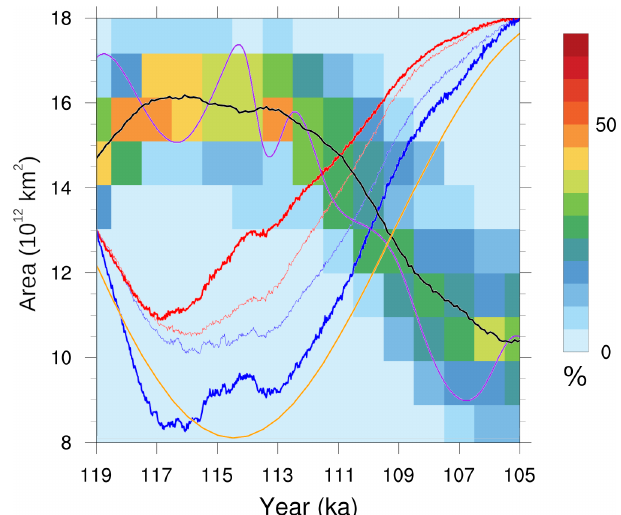
Figure 12. The ensemble distribution of Northern Hemisphere late summer sea ice total area. The black line shows the ensemble mean late summer sea ice area. The blue lines show the scaled ensemble mean summer temperature anomaly with respect to 119ka in NA (thick) and EA (thin). The red lines show the scaled ensemble mean annual precipitation anomaly with respect to 119ka in NA (thick) and EA (thin). The orange line represents the summer insolation at 60 ◦ N. The purple line shows the changes in log( p CO 2 ) to approxi- mately capture its effective radiative forcing. Temperature, precipi- tation, insolation, and p CO 2 are plotted solely for the sake of phase comparison, and therefore their actual values are not